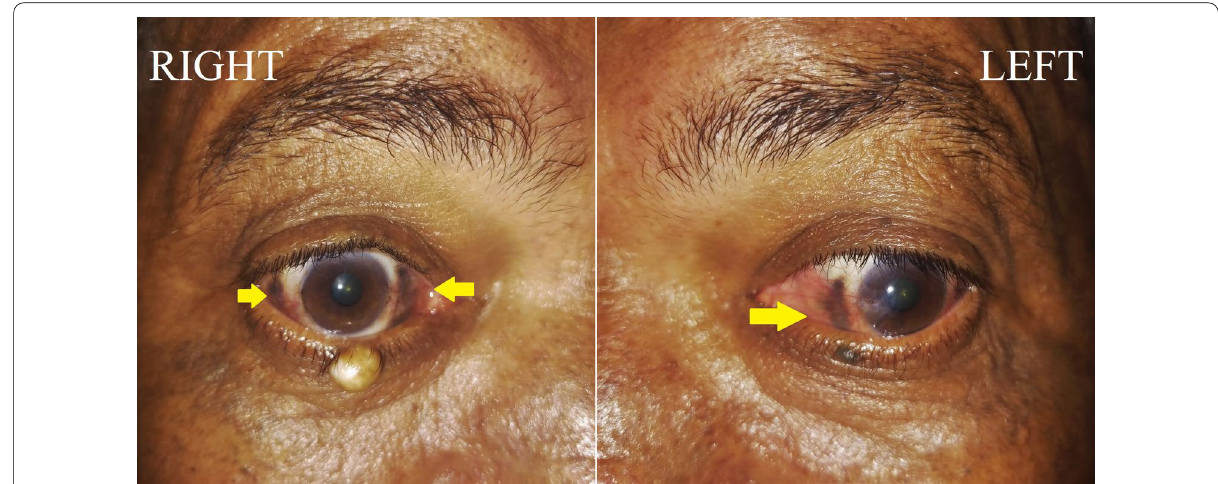
Fig. 1 Clinical image of the patient eyes showing a blackish discoloration of the sclera (Osler signs) indicated by yellow